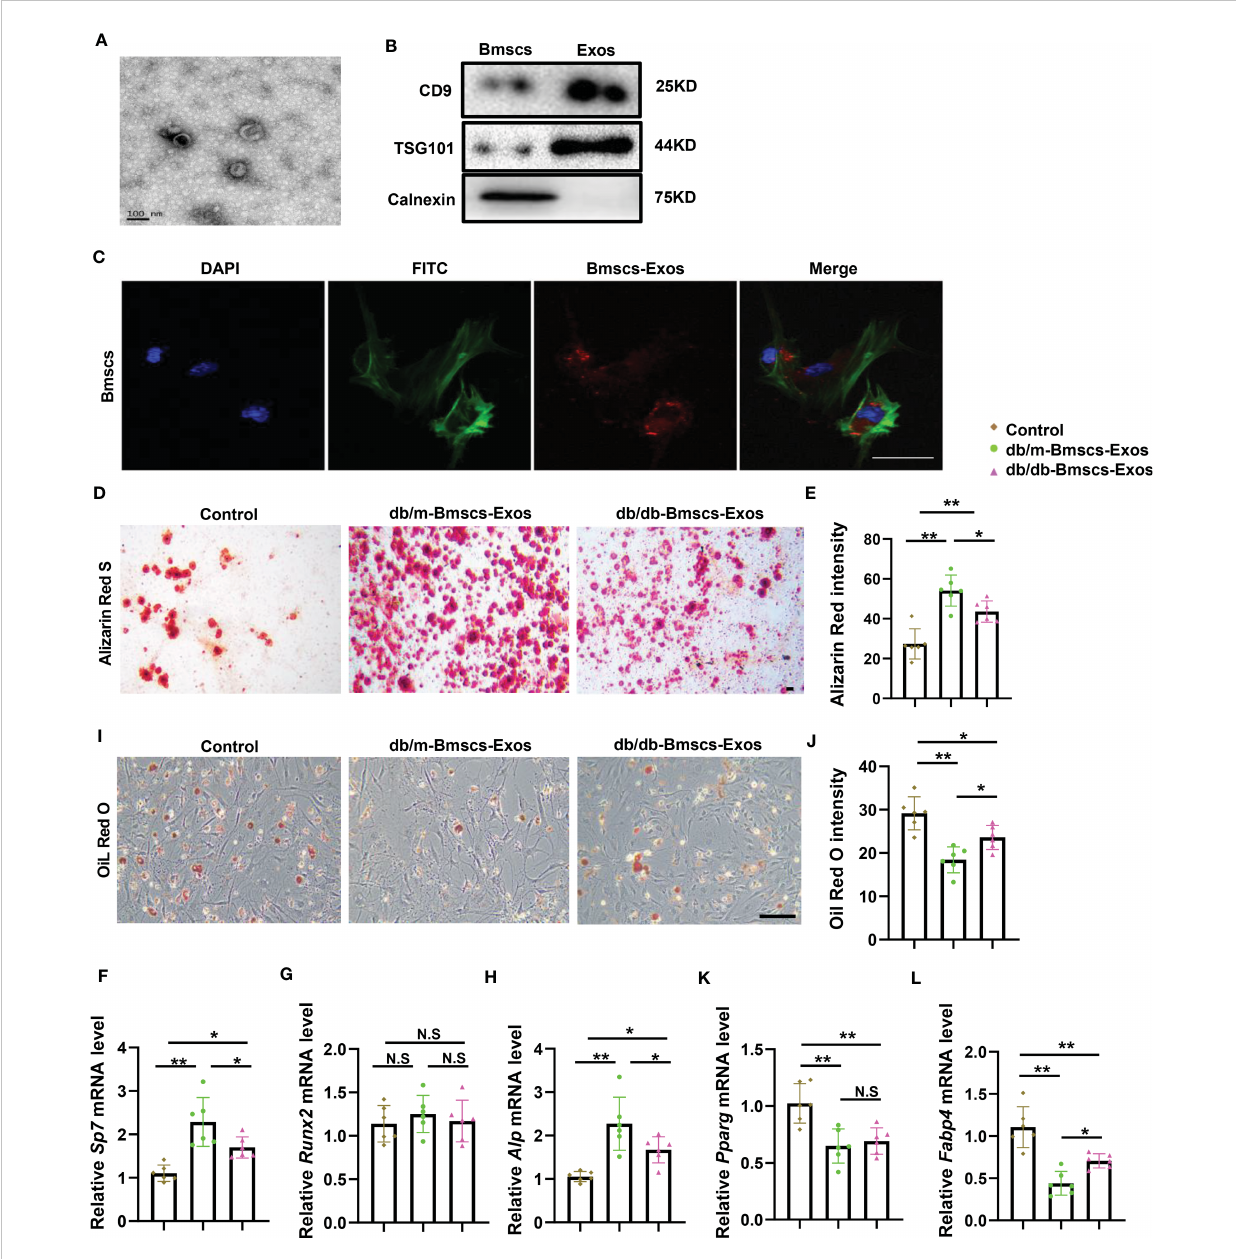
FIGURE 2 BMSCs derived exosomes from diabetic mice showed impaired ability of promoting osteogenesis and inhibiting adipogenesis. (A) Electron microscopy (sem) images of BMSCs-derived Exosomes (BMSCs-Exos) collected by ultracentrifugation. Scale bar: 100 nm. (B) Western blot of Exosomes markers, CD9, TSG101 and calnexin, full-length blots are presented in Supplementary Figure 1A-C. (C) 100ug/ml BMSCs-Exos was added to BMSCs and incubated for 12h. The representative image of BMSCs uptake the BMSCs-Exos. Blue fl uorescence marks the DAPI-labeled nucleus, green fl uorescence marks phalloidin-labeled cytoskeleton, red fl uorescence marks PKH26-labeled BMSCs-Exos. Scale bar: 100um. (D-L) Staining of BMSCs-Exos from diabetic mice and normal mice cultured in osteogenic induction medium and adipogenic induction medium for 14 days. qRT- PCR analysis of BMSCs-Exos from diabetic mice and normal mice cultured in osteogenic induction medium and adipogenic induction medium for 3 days. The representative images of matrix mineralized ash (D) and quanti fi cation of Alizarin Red S staining (E) , Scale bar: 100 m M; mRNA expression levels of osteogenic gene, Sp7 , Runx2 and Alp , respectively (F-H) , n=6 per group. Representative images of lipid droplet, Scale bar: 100 m M (I) and quanti fi cation of Oil Red O staining (J) ; mRNA expression levels of adipogenic gene, Pparg and Fabp4 , respectively (K, L) , n=6 per group. The data is shown as the mean ± SD. * P <0.05, ** P <0.01, NS., not signi fi cant